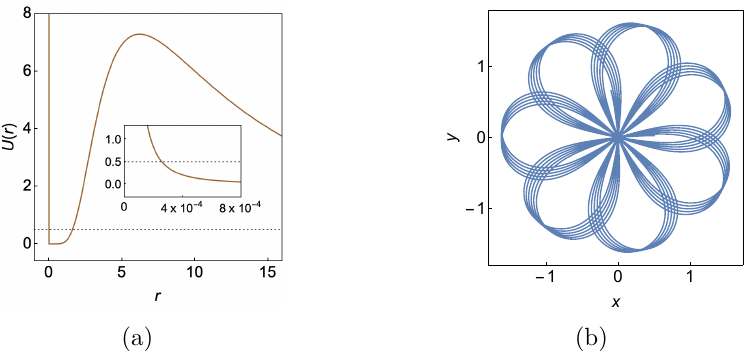
Figure 7 . Plot of the function (6.17).